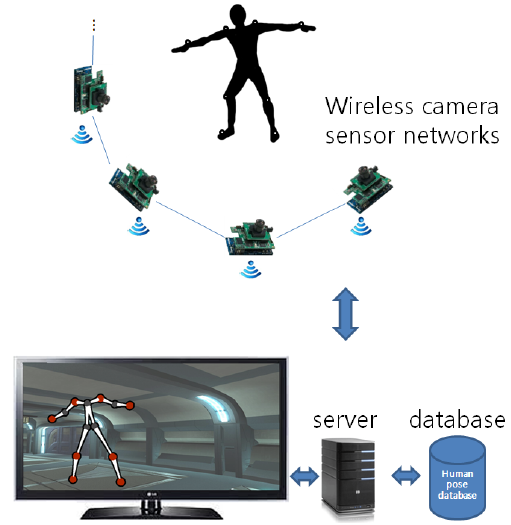
Figure 1. An overview of the Samba motion capture